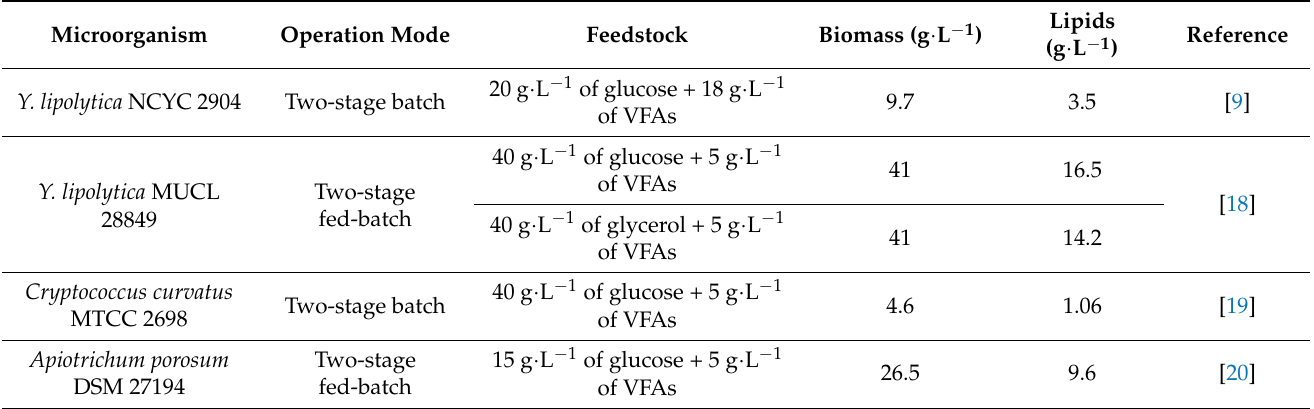
Table 3. Comparison of biomass and microbial lipids concentration obtained by different microbial species from VFAs in two-stage batch and two-stage fed-batch